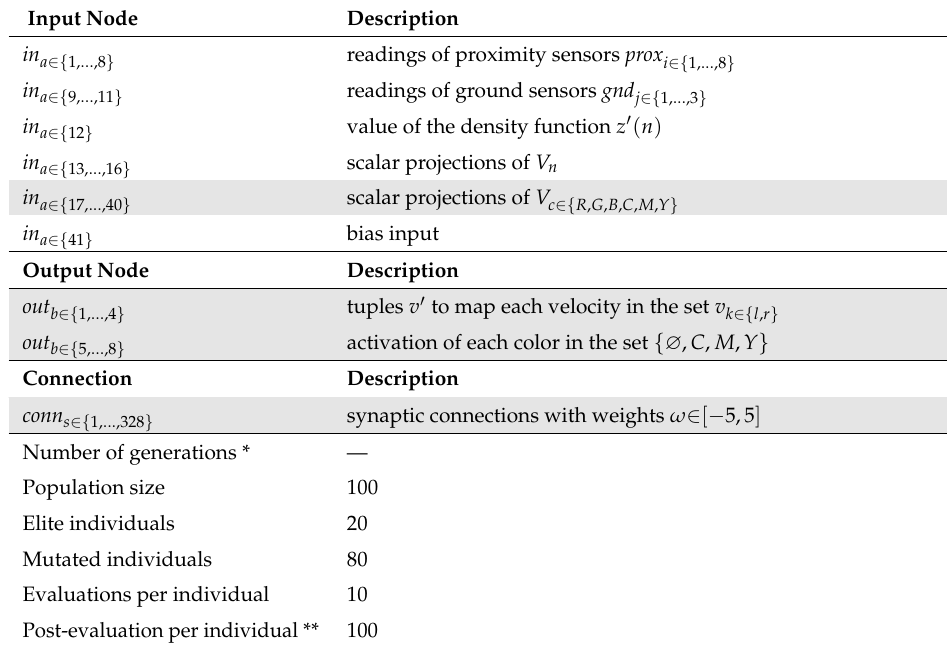
Table 3. Network topology and parameters of the evolutionary process in EvoColor . Novelties with respect to EvoStick are highlighted in gray. They concern the capability of displaying and perceiving colors. The neural network operates according to RM3, see Table